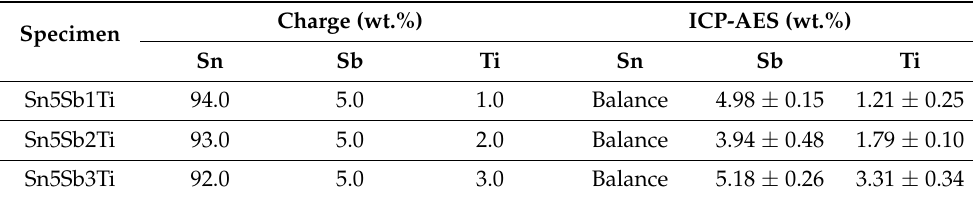
Table 1. Composition of the Sn–Sb–Ti alloy and the results of chemical analysis by the ICP-AES method (wt.%).